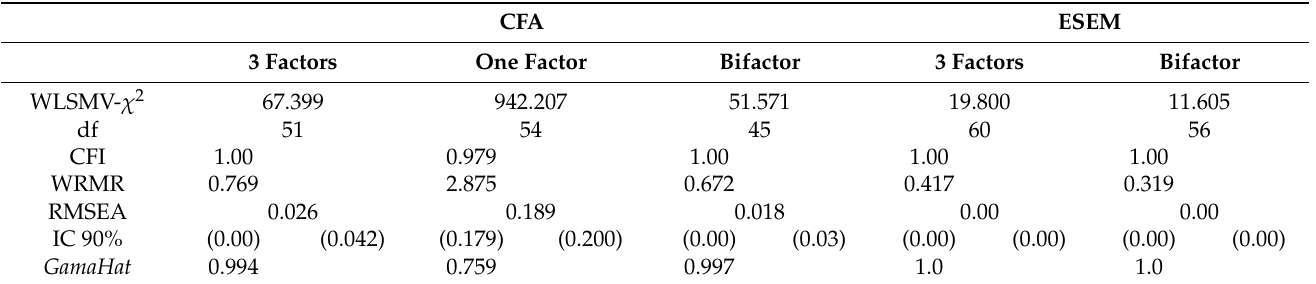
Table 3. Fit indicators of the main tested